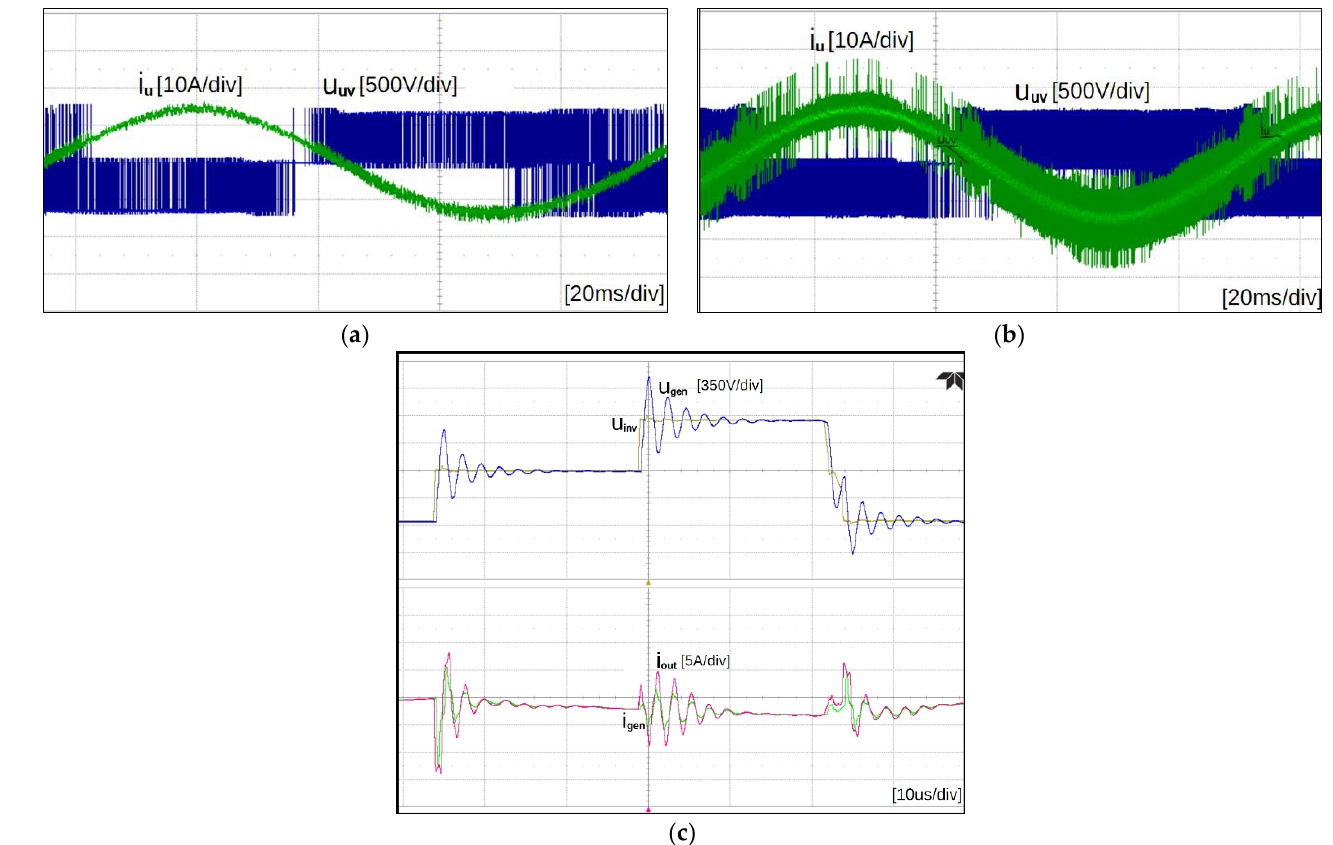
Figure 13. Generator voltage and current waveform from the side of: ( a ) generator converter, ( b ) generator and ( c ) the same waveforms in the reduced timescale window.